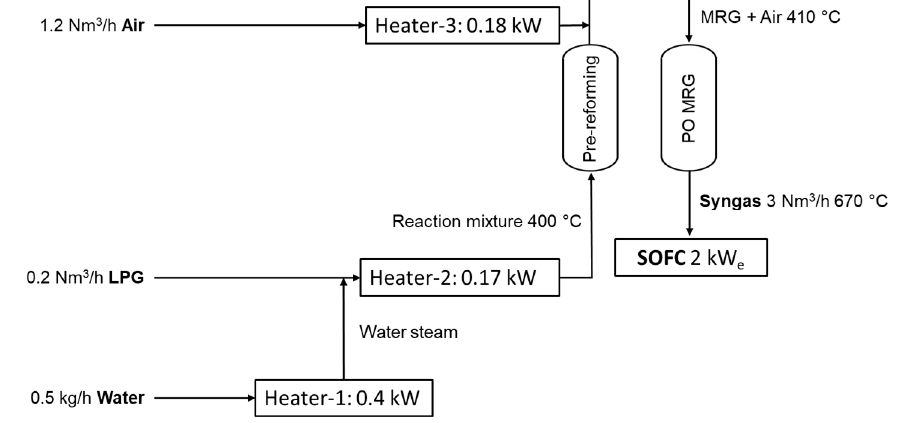
Figure 5. General scheme for the process of liquified petroleum gas (LPG) conversion to syngas for 2 kW e solid oxide fuel cell (SOFC).